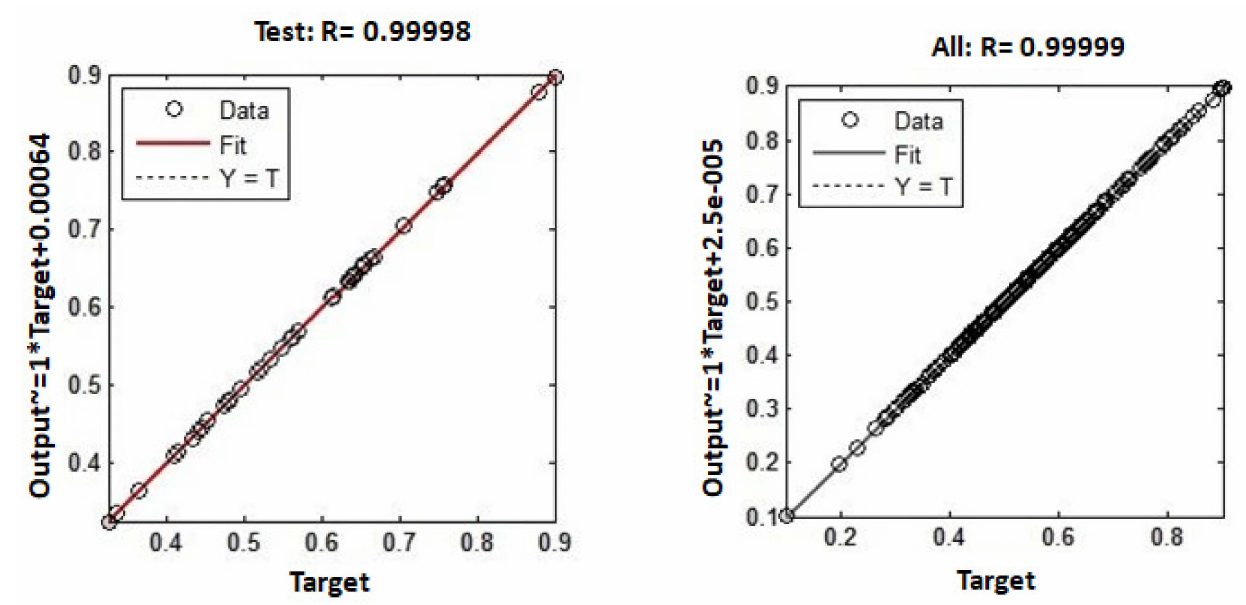
Figure 18. Regression graph of network 4-8-3 for angular distortion with time gap between two, three and four passes.